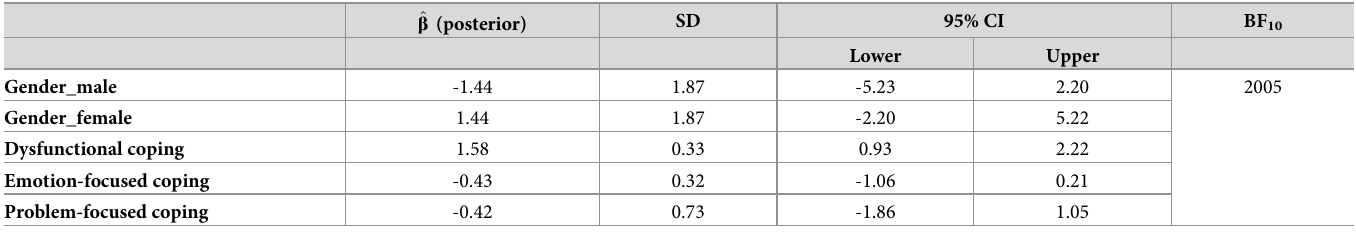
Table 5. Bayesian linear regression analysis with PCL-C score as the dependent variable.